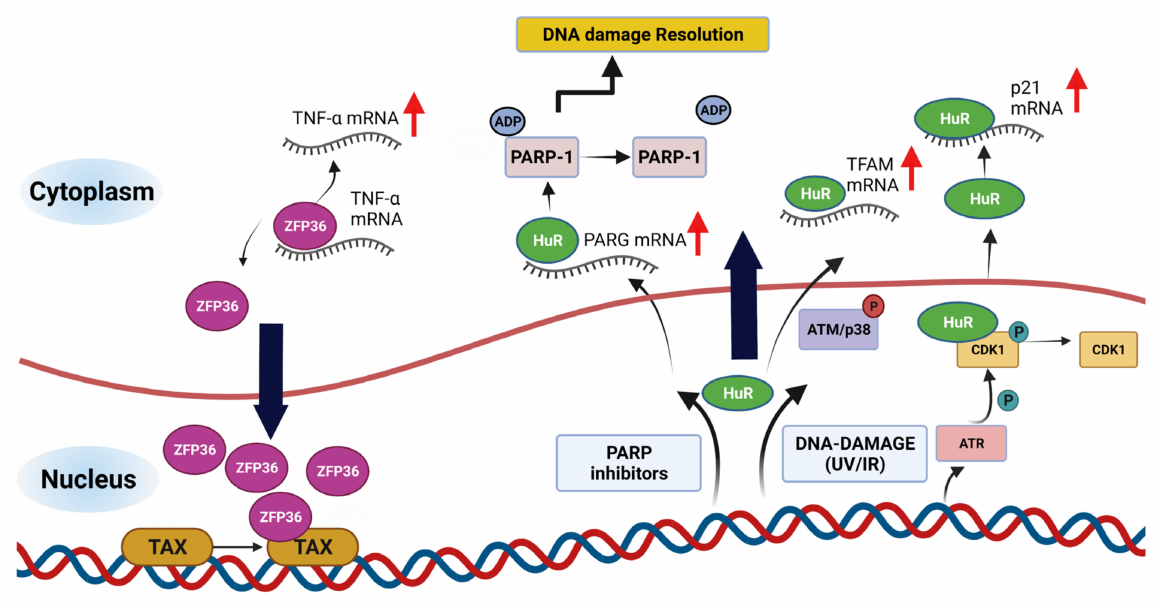
Figure 4. Subcellular environment dictates nucleocytoplasmic shuttling of AU-RBPs. In the nucleus, interaction of AU-RBP ZFP36 with retroviral transcriptional activator Tax protein results in shuttling of ZFP36 inside the nucleus and indirectly increase of TNF α mRNA in the cytoplasm. AU-RBP HuR translocates to cytoplasm in response to DNA-damage, resulting HuR binding and stabilisation of its mRNA targets including TFAM, PARG, CDKN1A. Bold black arrows indicate mobility of the AU-RBPs across the cellular compartments shown and red arrows indicate increased stability of the